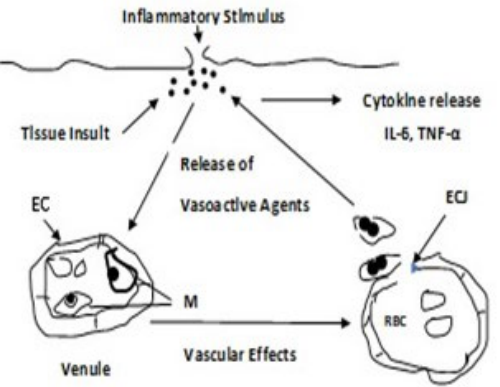
Figure 9. Acute Inflammatory Response. EC, endothelial cells; M, monocyte/macrophage; RBC, red blood cell; ECJ, endothelial cell junction. Upon tissue insult, several vasoactive and chemotactic substances are released at the injury site. The vasoactive substances act upon the endothelial cells of the venule, producing vascular effects. The activated macrophages escape through the endothelial cell junctions and are attracted to the inflammatory site where cytokines are released [60–62].